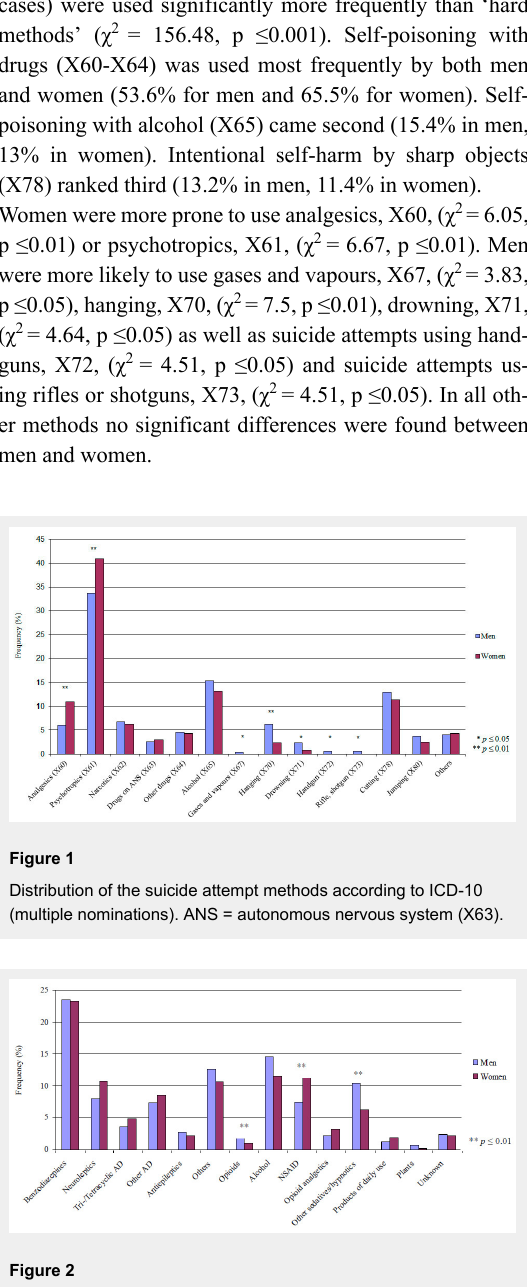
Distribution of used drugs in suicide attempts (multiple nominations). NSAID = nonsteroidal anti-inflammatory drug; AD =